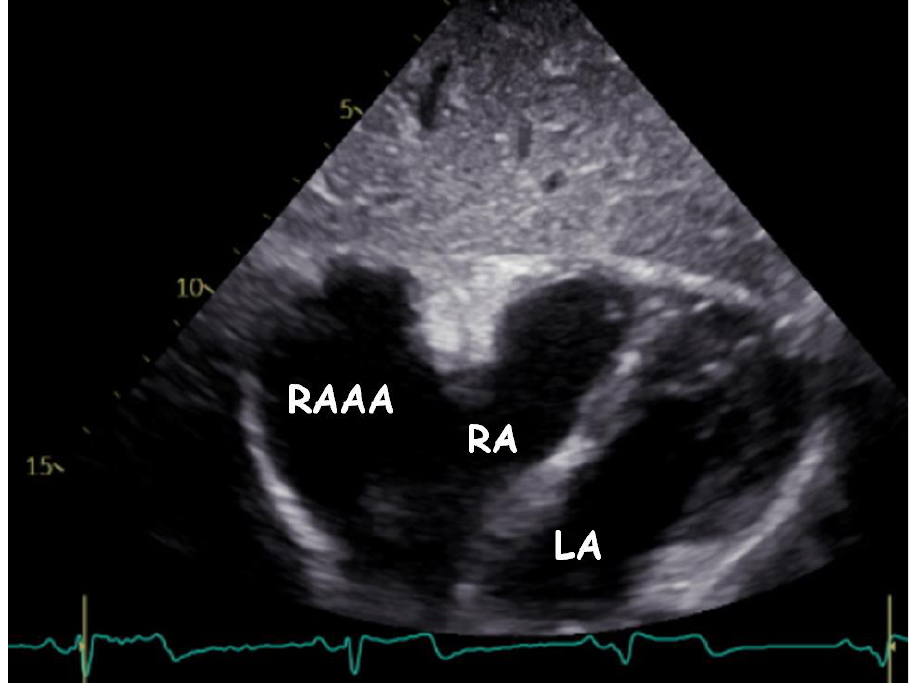
Figure 4. Transthoracic echocardiogram. Modified subcostal view showing the gigantic RAAA ten years later.